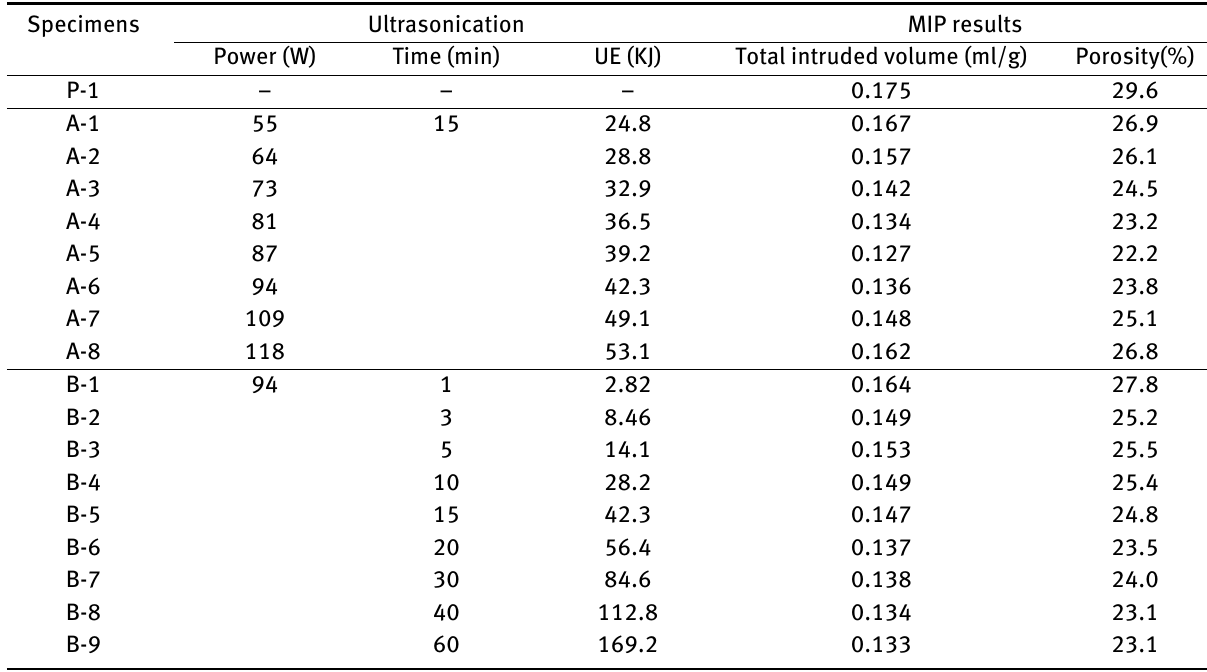
Table 4: Mercury intrusion porosimetry analysis of GO/MWCNT-OPC pastes. Specimens